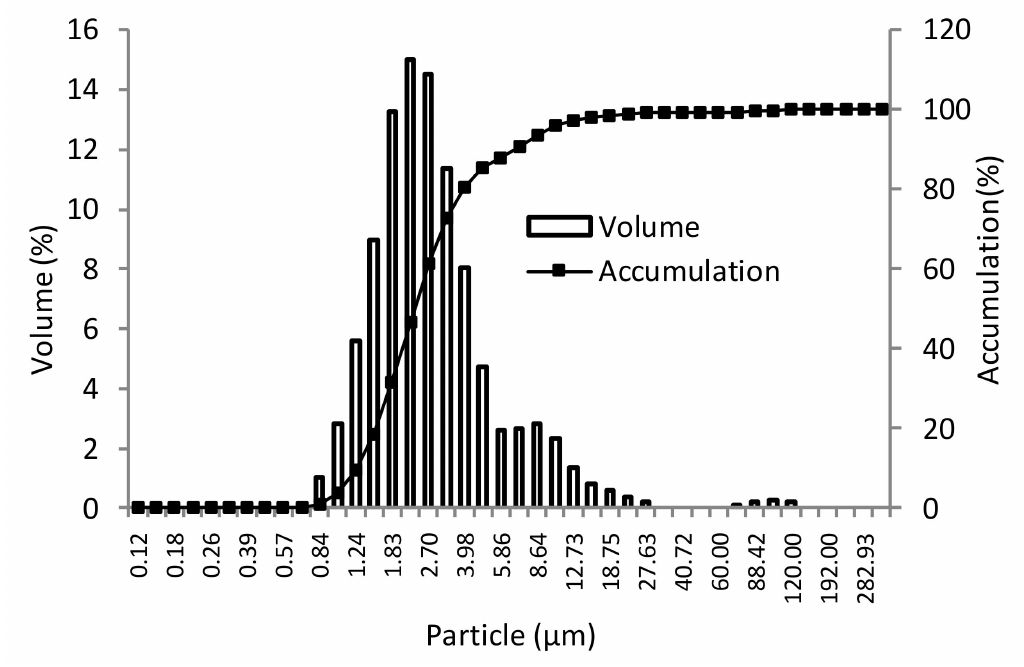
Figure 1. Waste concrete powder (WCP) particle distribution.